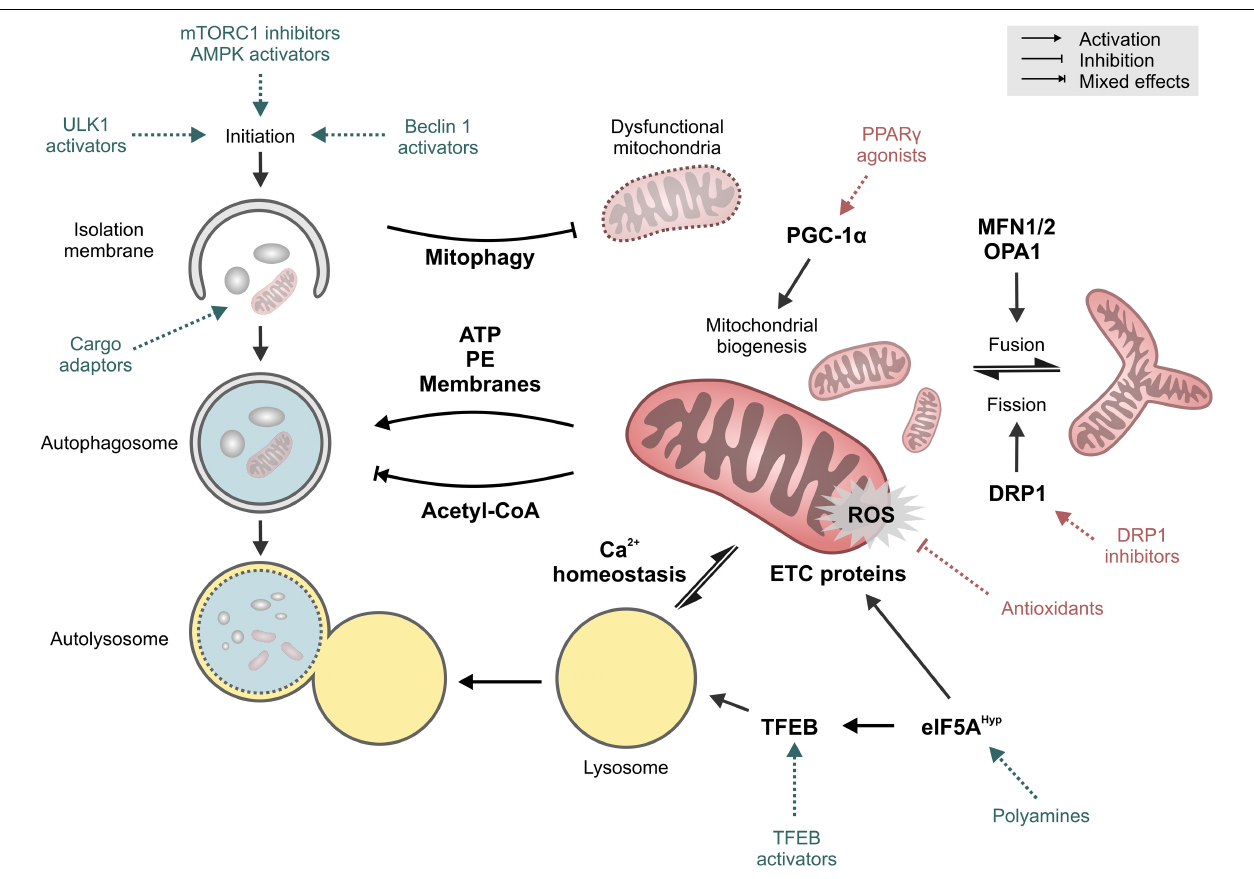
FIGURE 2 | Key targets and mechanisms of crosstalk between autophagy and mitochondria. Pharmacological interventions that mainly target autophagy or mitochondrial function are shown in blue and red, respectively. See text for details. Abbreviations: DRP1, Dynamin-1-like protein; eIF5A Hyp , hypusinated Eukaryotic translation initiation factor 5A-1; ETC, electron transport chain; MFN1/2, Mitofusin-1/2; OPA1, Optic atrophy protein 1/Dynamin-like 120 kDa protein, mitochondrial; PE, phosphatidyethanolamine; PGC-1 α , Peroxisome proliferator-activated receptor gamma coactivator 1-alpha; PPAR γ , Peroxisome proliferator-activated receptor gamma; ROS, reactive oxygen species; TFEB, Transcription factor EB; ULK1, Unc-51-like kinase